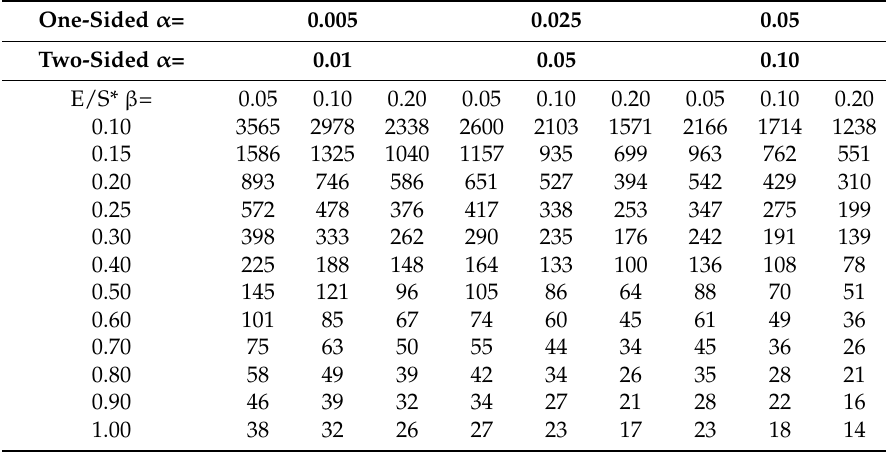
Table 3. Sample size required per